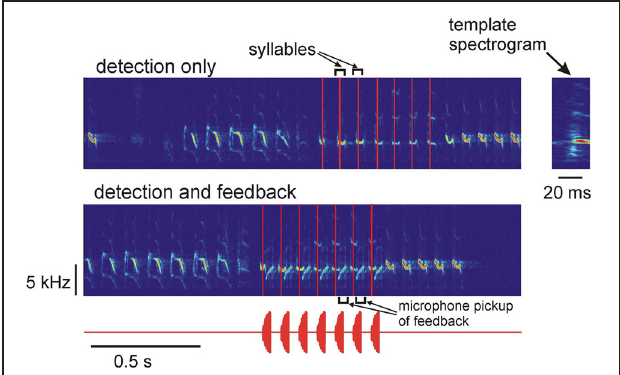
FIGURE 2 | Top: spectrogram of the song of a Bengalese finch and the times of occurrence of one of the song syllables. The system was programmed to only detect the occurrences of the target syllable in real time, no acoustic feedback was generated. The detection times are shown as vertical red lines. Bottom: the system is detecting the target syllables (vertical red lines) and is generating acoustic feedback after detection. The acoustic feedback waveform is shown below. The feedback signal is one of the birdsong syllables; the acoustic feedback pickup by the microphone is visible on the spectrogram. The zoomed-in spectrogram of the template is shown on the right.